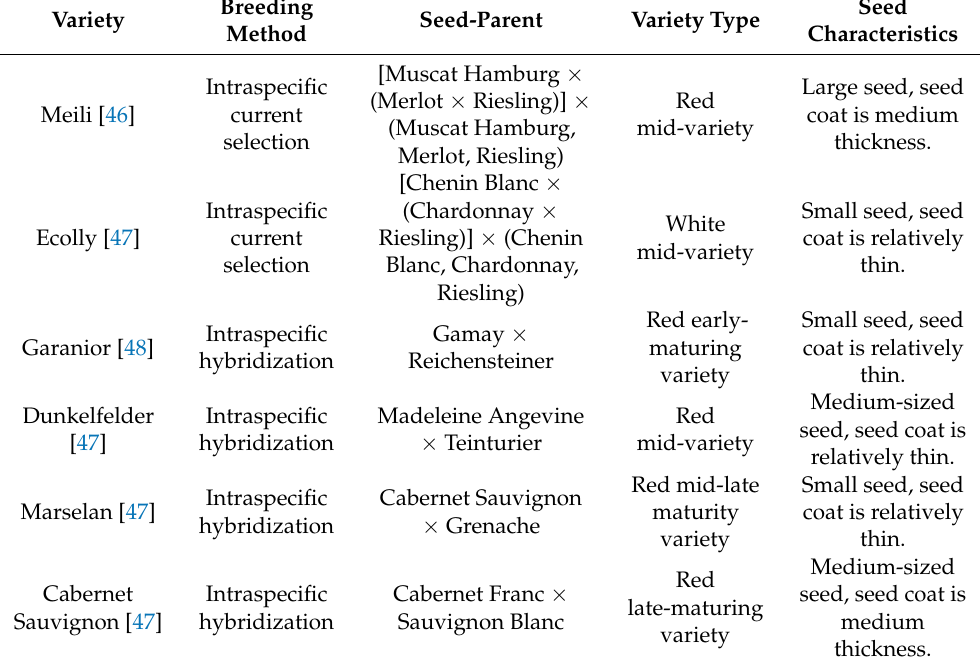
Table 8. Characteristics of the six test V. vinifera